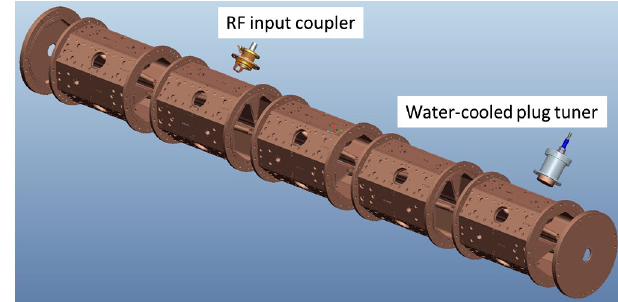
FIG. 6. 3D CAD model of the RFQ.